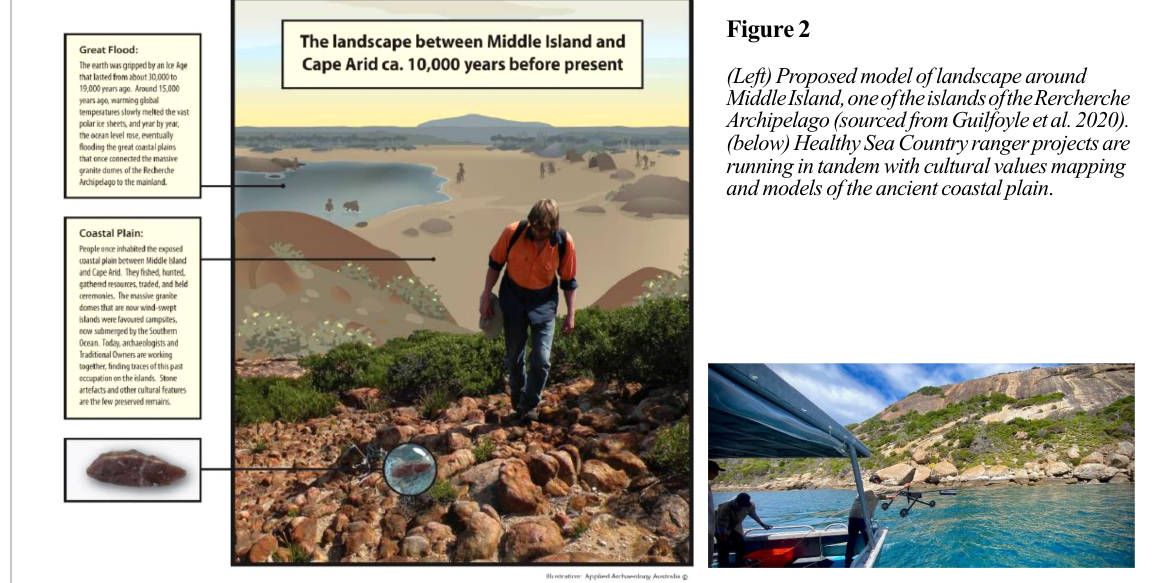
Figure 2 (Left)Proposedmodeloflandscapearound MiddleIsland,oneoftheislandsoftheRercherche Archipelago(sourcedfromGuilfoyleetal.2020). (below)HealthySeaCountryrangerprojectsare runningintandemwithculturalvaluesmapping andmodelsoftheancientcoastalplain